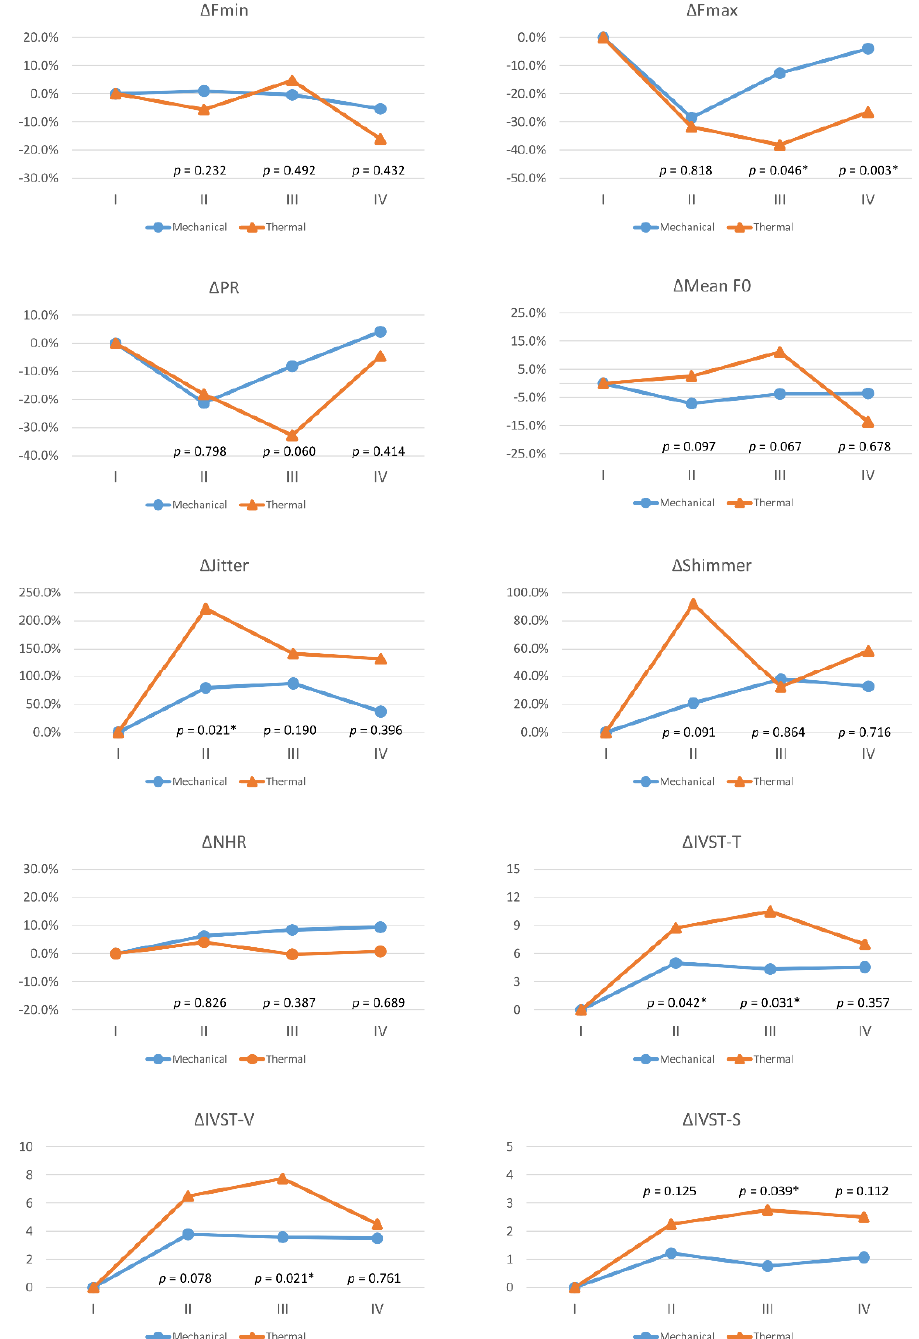
Figure 3. Voice parameter changes ( ∆ ) with different mechanisms of recurrent laryngeal nerve dys- function. Red lines and blue lines indicate mechanical injury and thermal injury, respectively. Abbre- viations for objective/subjective voice parameters and definitions of follow-up periods (I/II/III/IV) are identical to those in Figure 2. The equation for calculating postoperative change in objective voice parameters (Fmax, Fmin, PR, mean F0, jitter, shimmer, NHR) was ∆ = (B − A)/A, where the unit is %; the equation for calculating postoperative change in subjective voice parameters (IVST-T, IVST-V, IVST-S) was ∆ = B − A, where the unit is score. Values A and B are preoperative and postoperative val- ues, respectively. The preoperative ∆ is 0 for all voice parameters. Asterisk represents p value < 0.05, showed significant